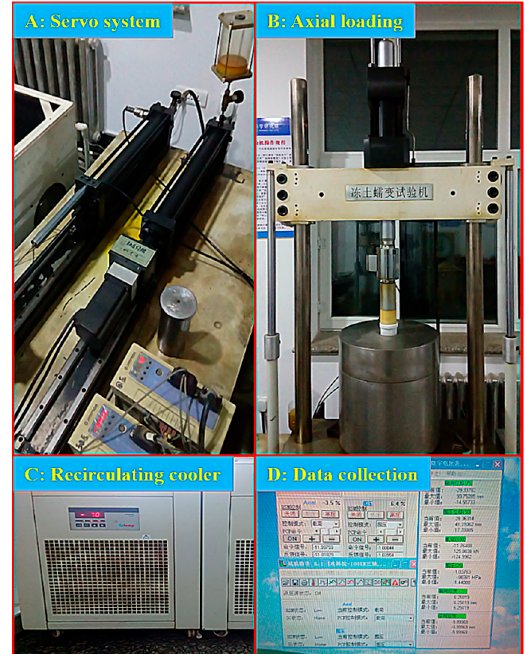
Figure 3. Triaxial shear apparatus for frozen soil.